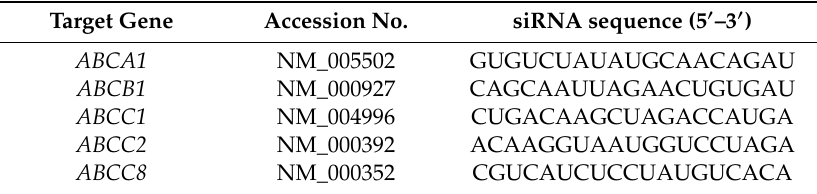
Table 1. The siRNA sequences of ABC transporters.